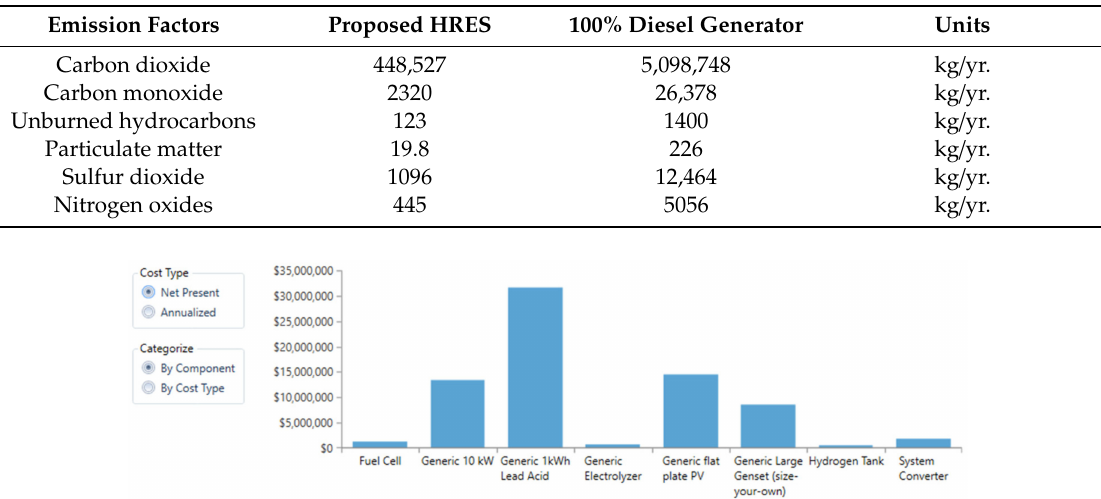
Figure 10. The hydrogen production of the optimal configuration. Table 5. The emissions of the optimal configuration.